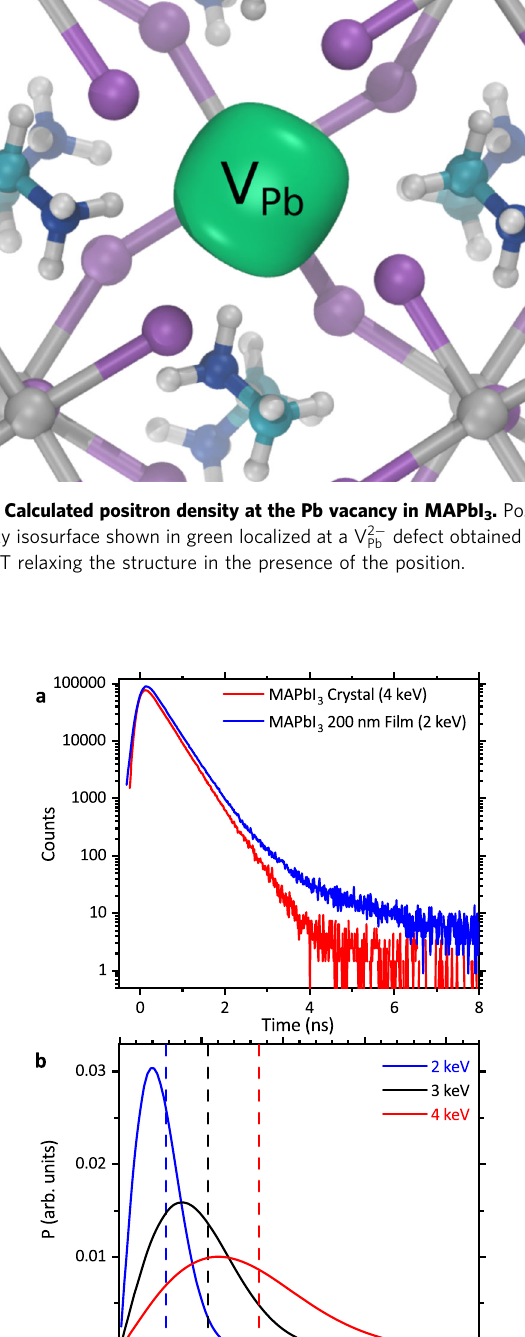
Fig. 3 Experimental positron lifetime spectra and positron implantation pro fi les. a Lifetime spectra for a 200 nm MAPbI 3 fi lm (Oxford), (blue) measured with 2 keV positron implantation energy and for a MAPbI 3 crystal (red) at 4 keV. b Markovian positron implantation depth pro fi les, the mean depths are shown with dashed lines.